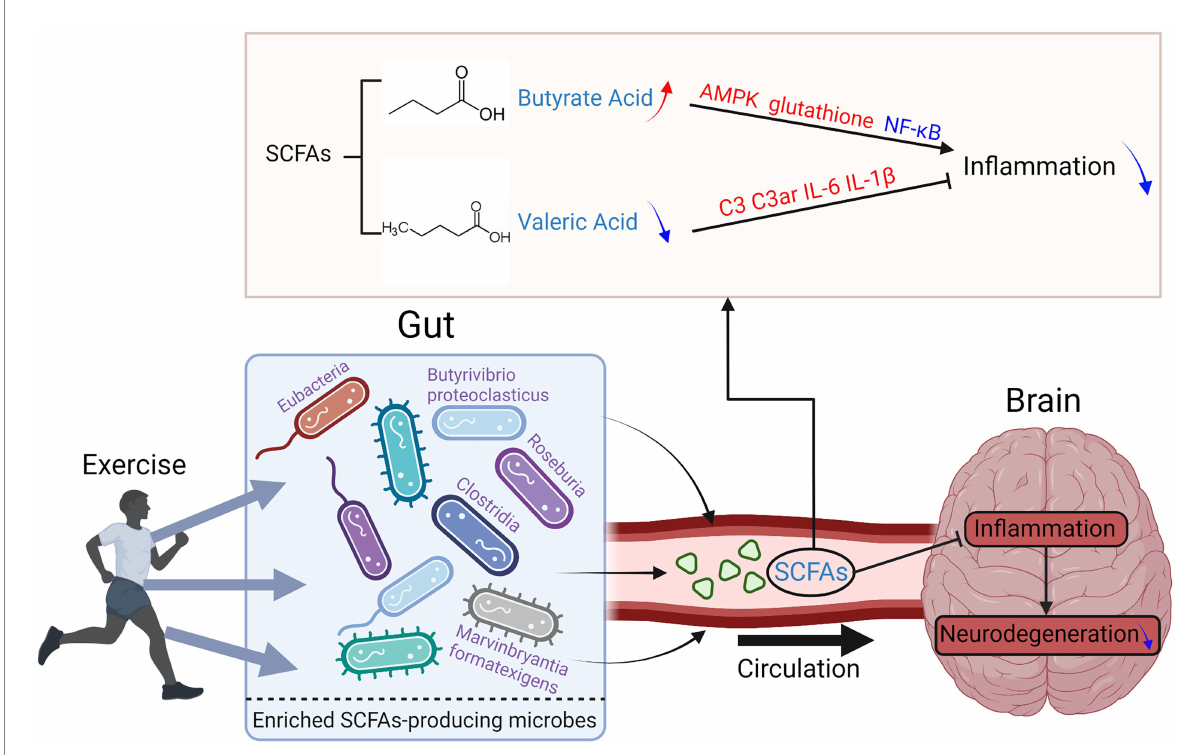
FIGURE 4 Exercise reduces the inflammation levels of the brain in neurodegenerative diseases by regulating the composition of SCFAs-producing gut